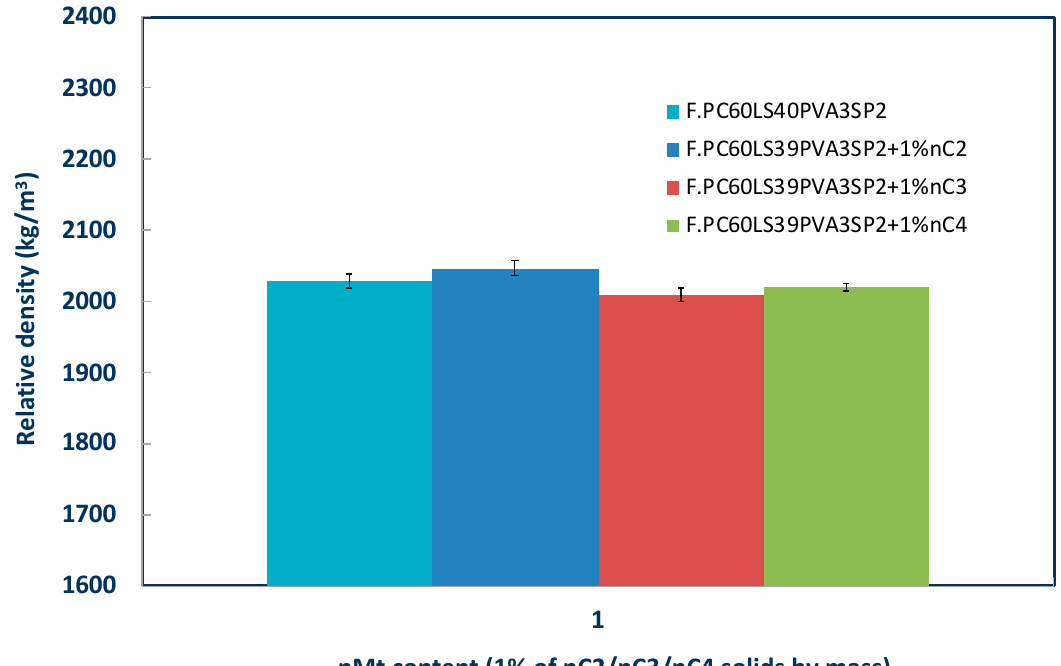
Figure 11. E ff ect of nMt type (at 1% dosage) on long term relative density of fiber–cement nanohybrids based on F.PC60LS40PVA3SP2.